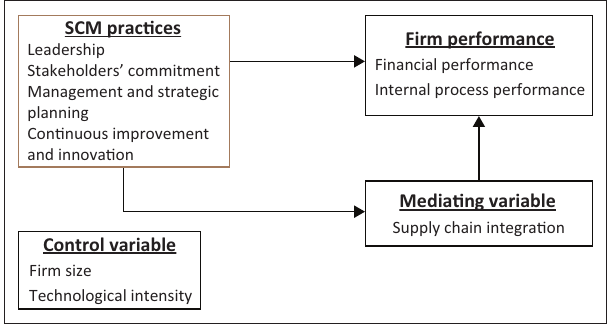
Figure 1: Framework of the